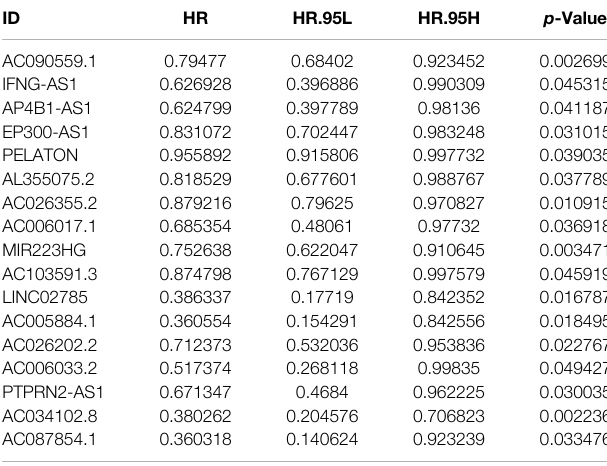
TABLE 1 | Results of univariate Cox